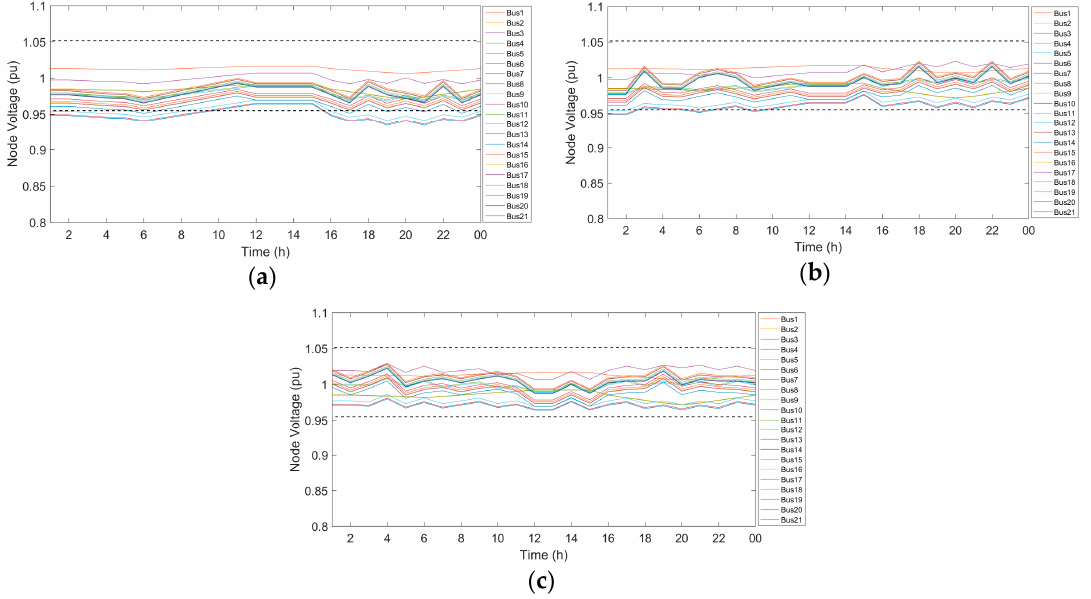
Figure 7. Node voltages of solution C for all tap position constraints ( g A – g C ). ( a ) Node voltages (equality constraint of g A ); ( b ) node voltages (equality constraint of g B ); ( c ) node voltages (equality constraint of g C ).